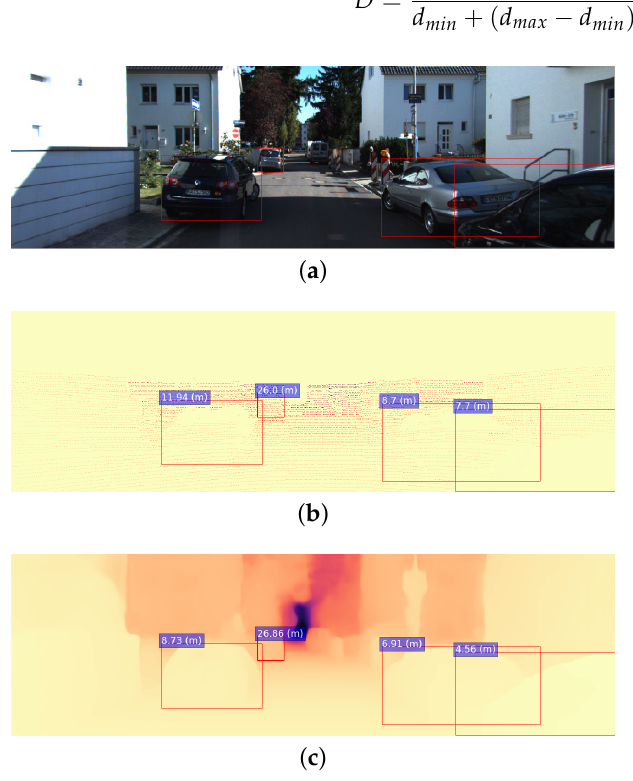
Figure 1. ( a ) A sample image from the dataset with the bounding boxes obtained with YOLOv5; ( b ) its corresponding LIDAR point cloud; ( c ) the depth map generated by Monodepth2. Ground-truth distances and Monodepth2 object distances are shown in blue